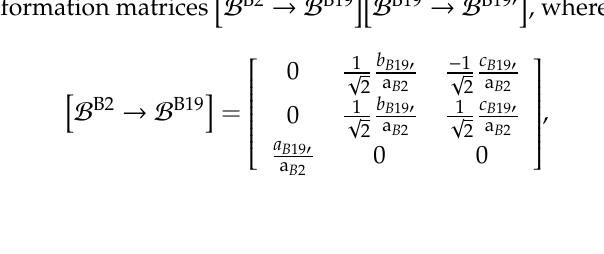
Figure 16. Distribution of the values λ 1 and λ 3 of di ff erent cubic-orthorhombic transformations in Ti-based shape memory alloys from [31], and the curve (quasi-line) y = √2 − (cid:1876) (cid:2870) in a green dash color predicted if one assumes the invariance of the diagonal line between the eigenvectors associated with λ 1 and (cid:2019) 3 .